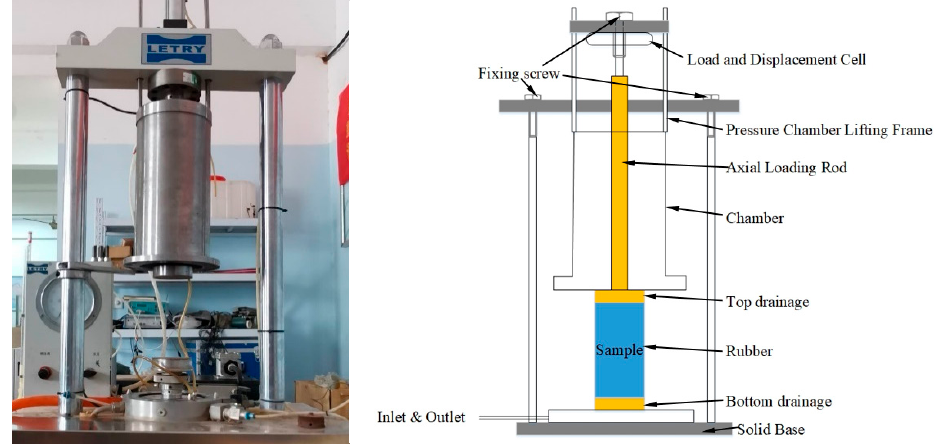
Figure 3. The apparatus used for laboratory monotonic and repeated load triaxial compression tests.